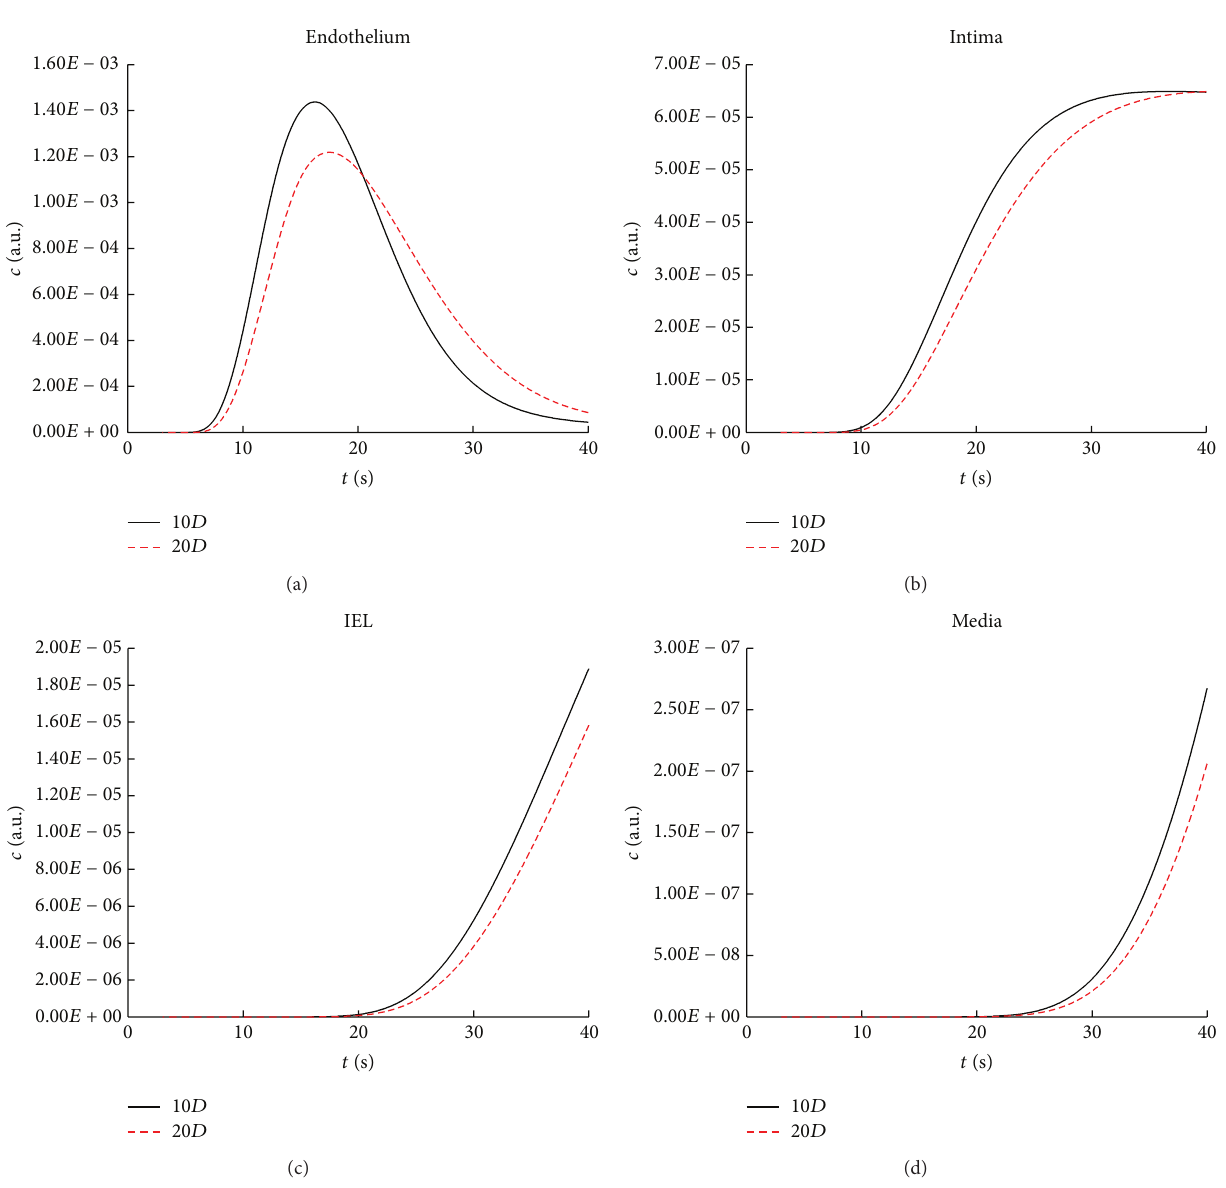
Figure 3: The concentration-time curves across the arterial wall at the axial direction of 10𝐷 and 20𝐷 in the model with arterial transmural